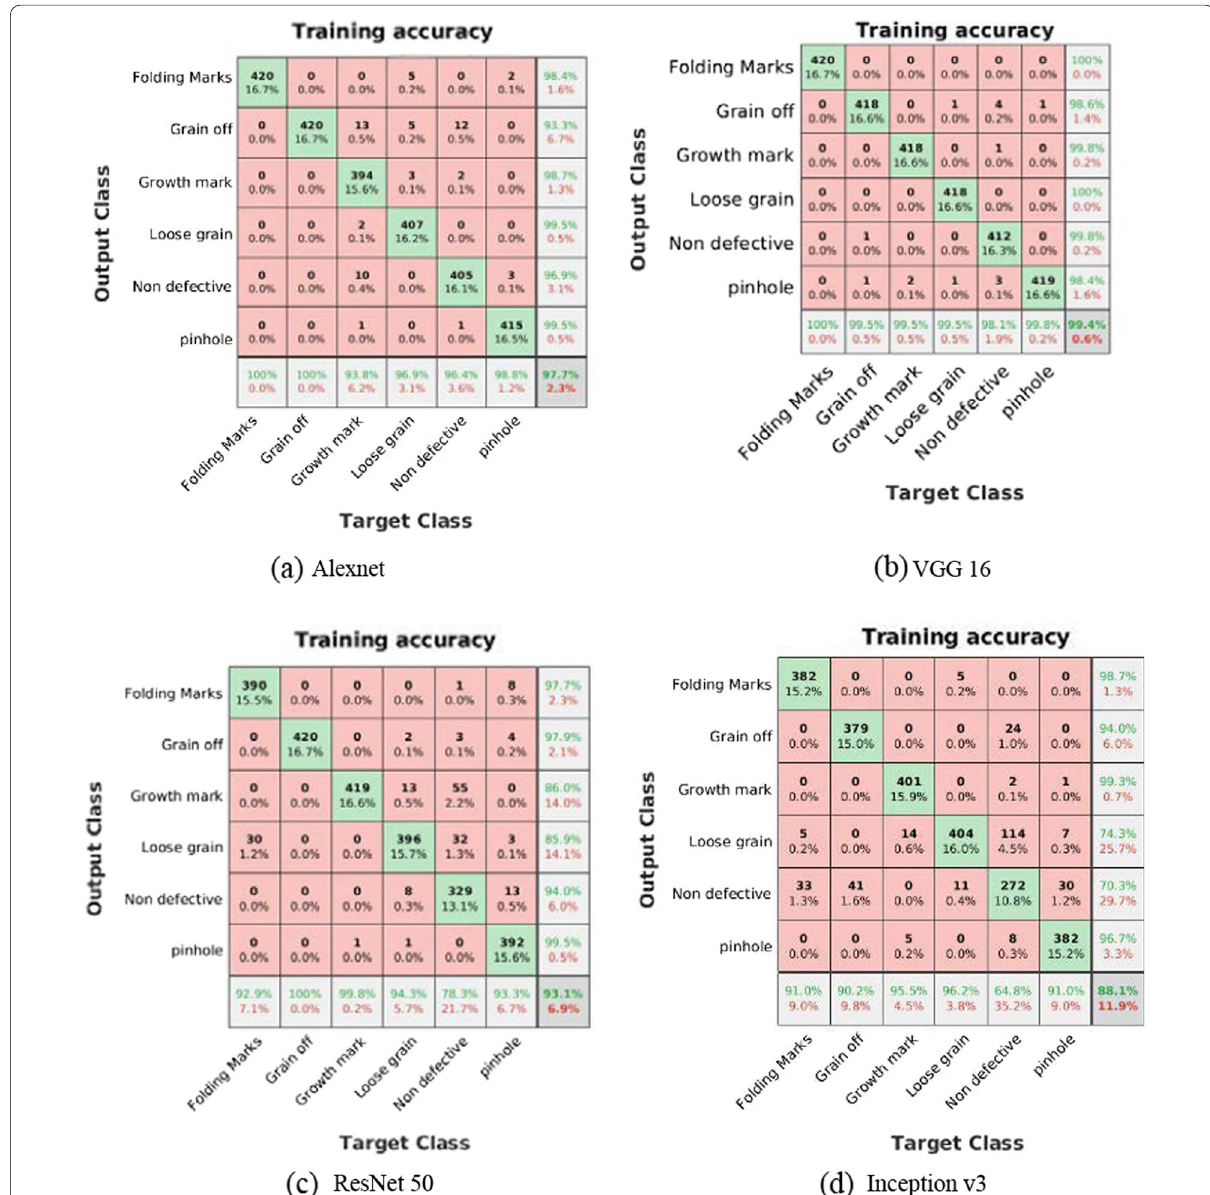
Fig. 12 Comparision of classification accuracy of the deep learning convolution neural network